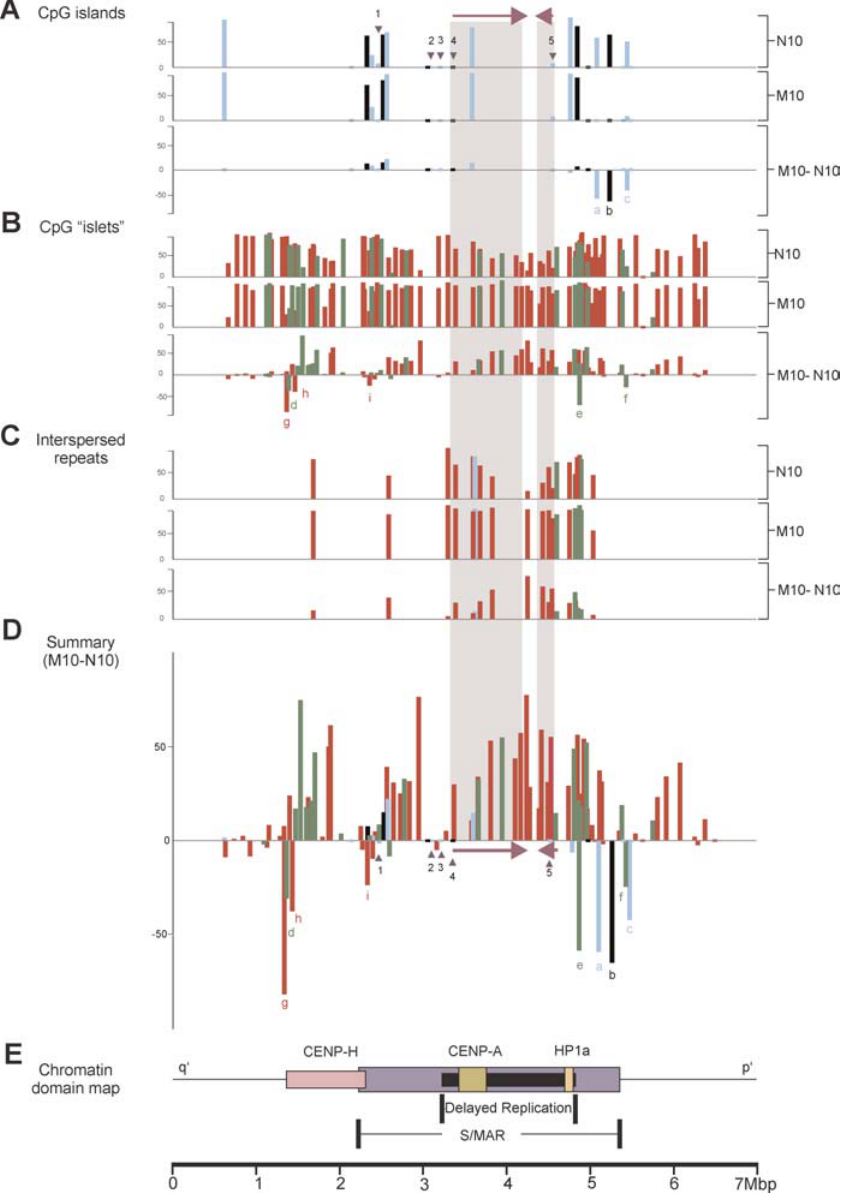
Figure 2. DNA-Methylation Profiles for 129 Separate CpG Islands and Islets Profiles apply across a 6.76-Mbp DNA section of the 10q25 region before (N10) and after (M10) neocentromere formation. The y -axis shows the percentage methylation in CHO–N10 and CHO–M10, and the percentage methylation difference (CHO–M10 minus CHO–N10). (A) Classically defined CpG islands [15] are represented by blue bars, while CpG islands conforming to the modern definition [22] are identified by black bars. Genes previously shown to be expressed in both CHO–N10 and CHO–M10 and known to be associated with a 5 9 CpG island are labeled (1) FLJ10188, (2) KIAA1600, (3) TRUB1, (4) ATRNL1, and (5) GFRA1, with the position of their 5 9 -associated CpG islands indicated by inverted triangles, and the direction of transcription and the full extent of the two larger genes (4 and 5) indicated by the horizontal arrows and shaded areas, respectively. (B) CpG islets analyzed in this study with lengths ranging from 100 to 200 bp (green bars) or 50–99 bp (red bars). (C) Methylation levels of CpG islets identified as retrotransposable and other interspersed repetitive elements analyzed in this study. The full extent of the two larger genes (4 and 5) is indicated by the shaded areas. The length of CpG islets ranges from 100 to 200 bp (green bars) or 50–99 bp (red bars). (D) Summary of percentage methylation difference between CHO–M10 and CHO–N10. Three CpG islands and six CpG islets that are hypomethylated in M10 compared to N10 are denoted by a–i. (E) Relative positions of previously described chromatin domains corresponding to foundation centromeric proteins CENP-H and CENP-A, heterochromatin protein HP-1 a , and enhanced S/MAR regions [32], and a region of delayed DNA replication [30]. DOI: 10.1371/journal.pgen.0020017.g002